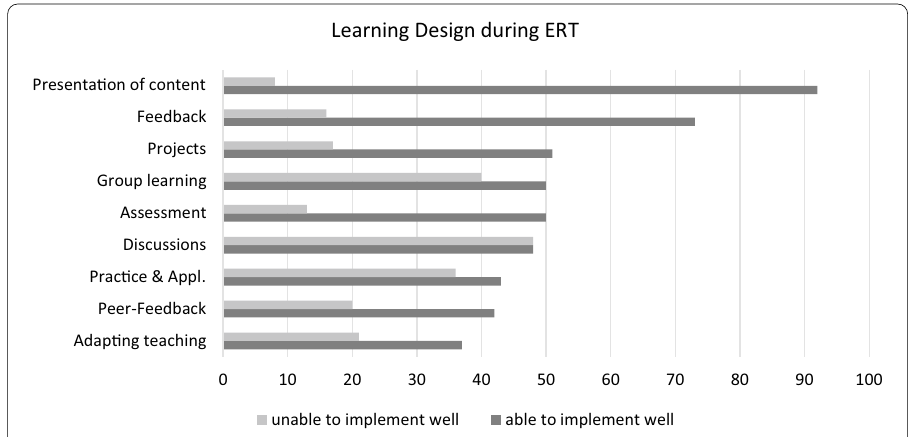
Fig. 2 Perceived (in-)ability of HE lecturers to implement learning design features during